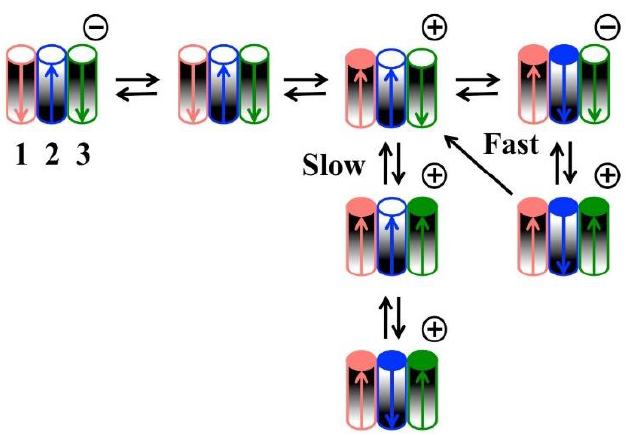
Figure 1. Model of the voltage gating of Triplin, as published in [9].